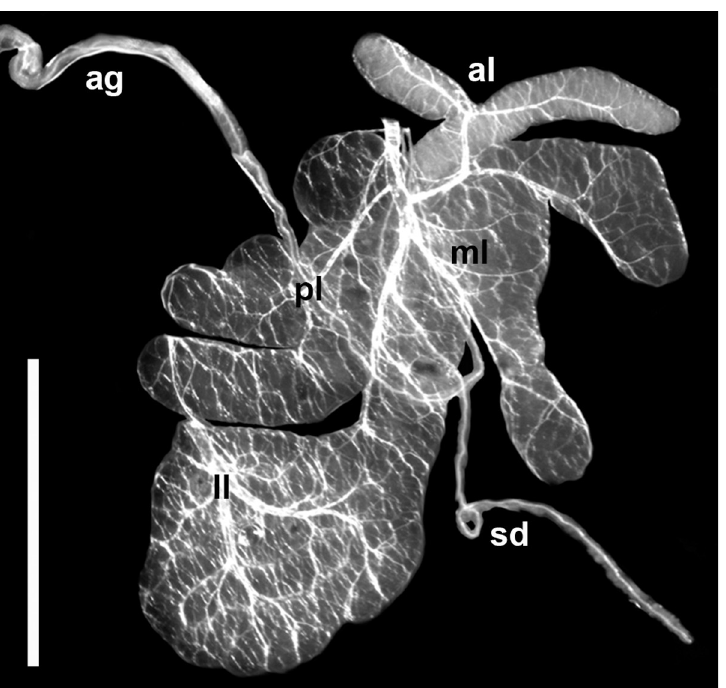
Fig 1. Isolated salivary gland of Coreus marginatus ( ex vivo , reflected light). ag –accessory Salivary gland; al – anterior lobe of the principal Salivary gland; ll– lateral lobe of the principal Salivary gland; ml– median lobe of